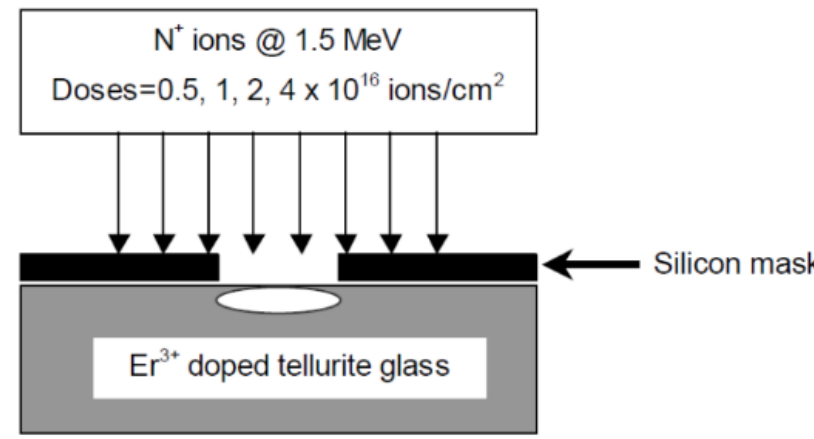
Figure 1. Fabrication of the channel waveguides by ion beam implantation through a silicon mask.